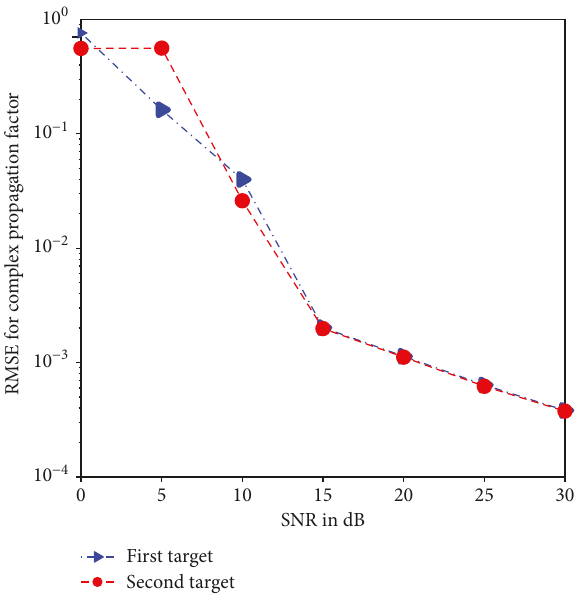
Figure 4: Root mean square error for the complex propagation factor magnitude vs. SNR in dB for γ = 0 4 .